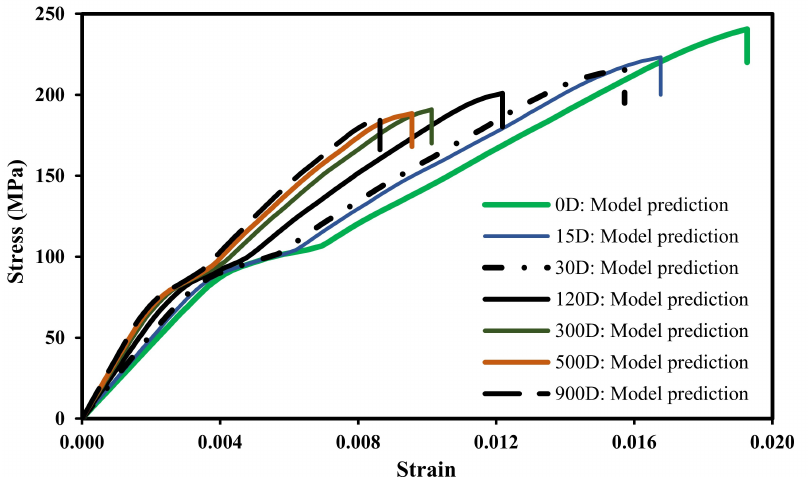
Figure 10. Stress–strain plot: model prediction of the effects of the seawater exposure for different immersion